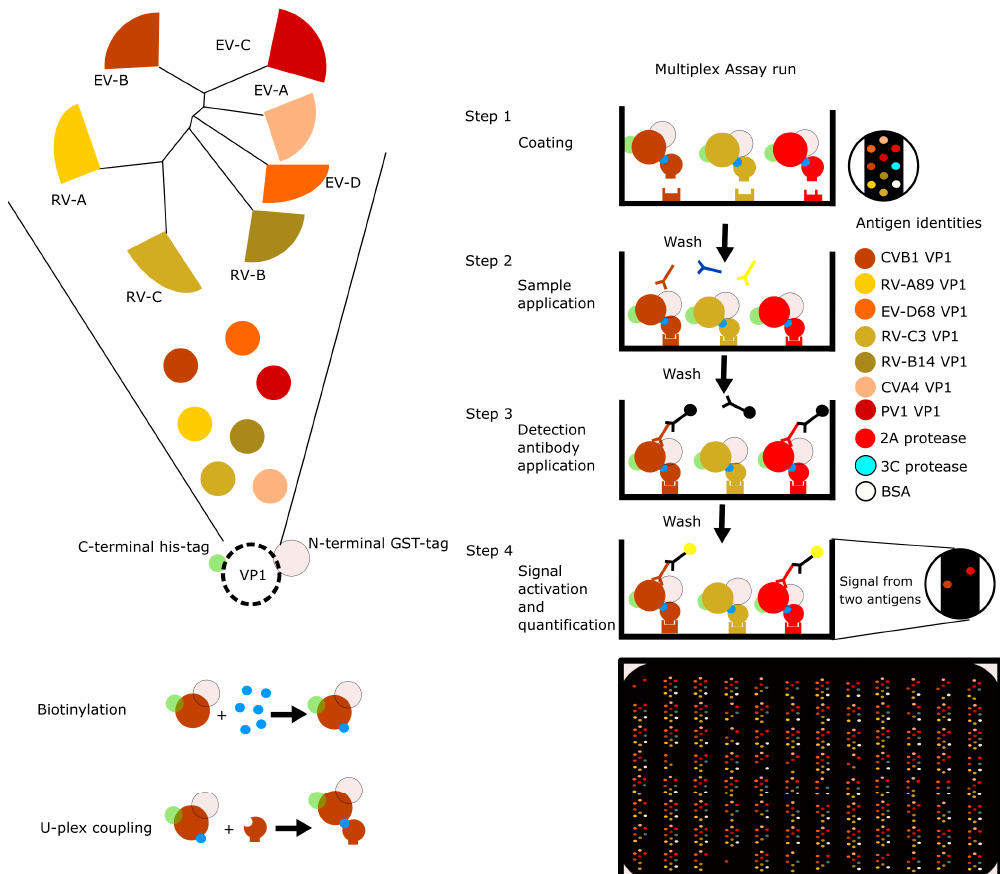
Figure 1. Multiplex assay development. Representative VP1 protein sequences from all human infecting enterovirus and rhinovirus species were equipped with an N-terminal GST-tag and a C-terminal 6xhis-tag for purification after bacterial expression. The purified recombinant VP1 proteins along with 2A and 3C proteases from CVB3 and a BSA control were biotinylated and each antigen was coupled to a unique U-PLEX linker. During coating each U-PLEX linker coupled antigen would target a specific site at the bottom of the well. After coating, the assay is run like a regular indirect ELISA, except for having a secondary antibody with electrochemiluminescence tag, and a suitable substrate and an MSD plate reader.